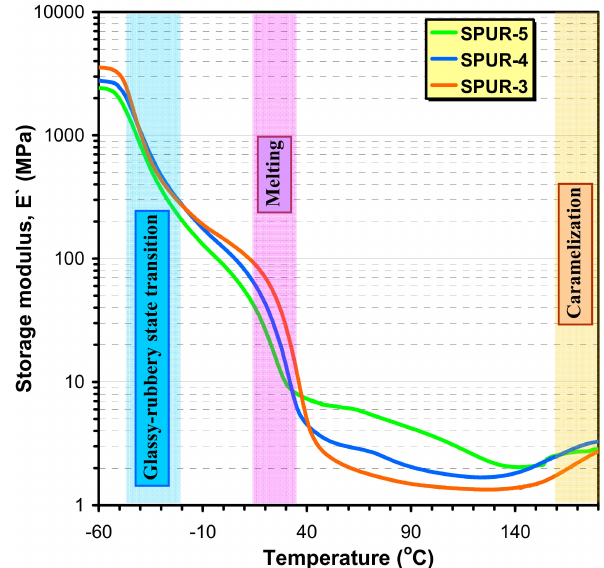
Figure 10. Variation of the storage modulus (E (cid:48) ) with the temperature for the samples SPUR-5, SPUR-4 and SPUR-3. (The DMA traces for the samples SPUR-1 and SPUR-2 are shown in Figures S8 and S9, respectively in the Supplementary